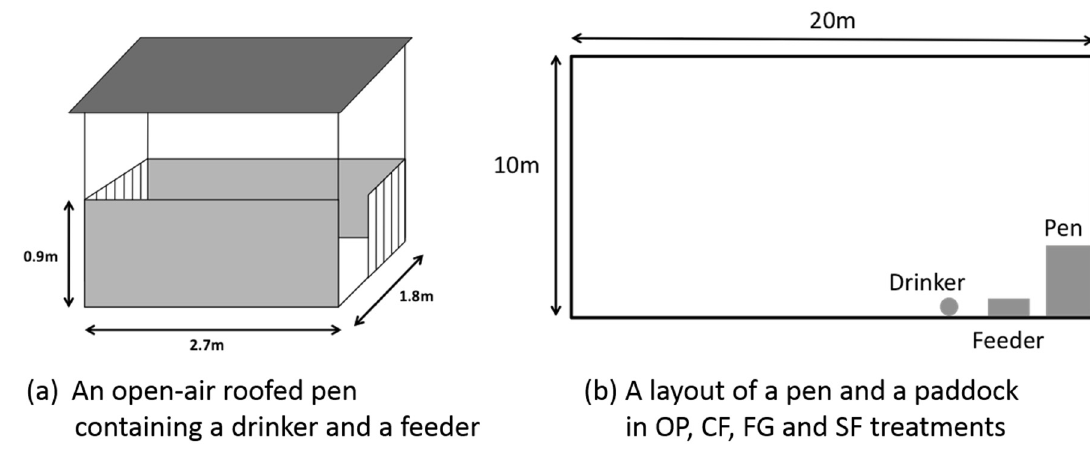
Figure 1. Schematic diagram of an open-air roofed pen and a